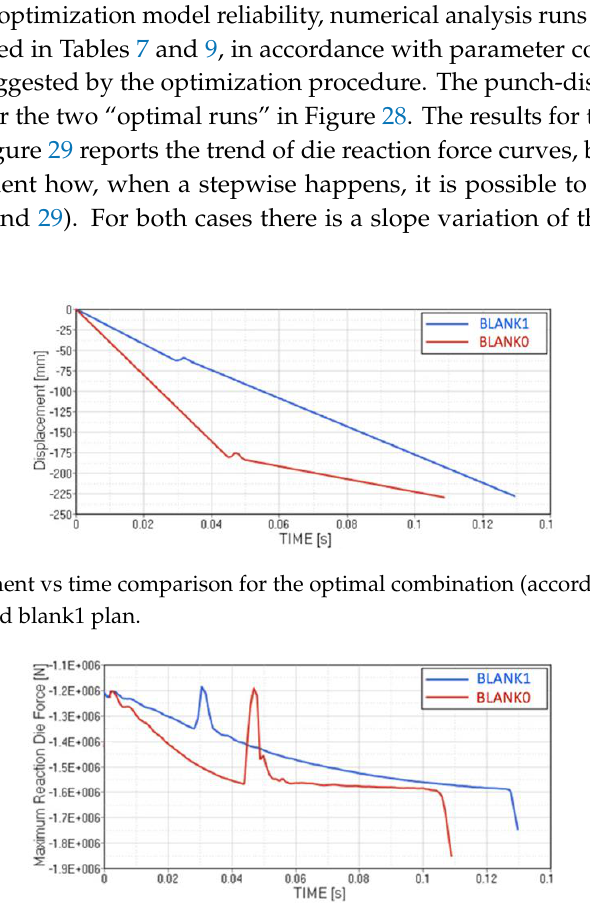
Figure 27 - Design explored with MIGA for the blank1 plan.